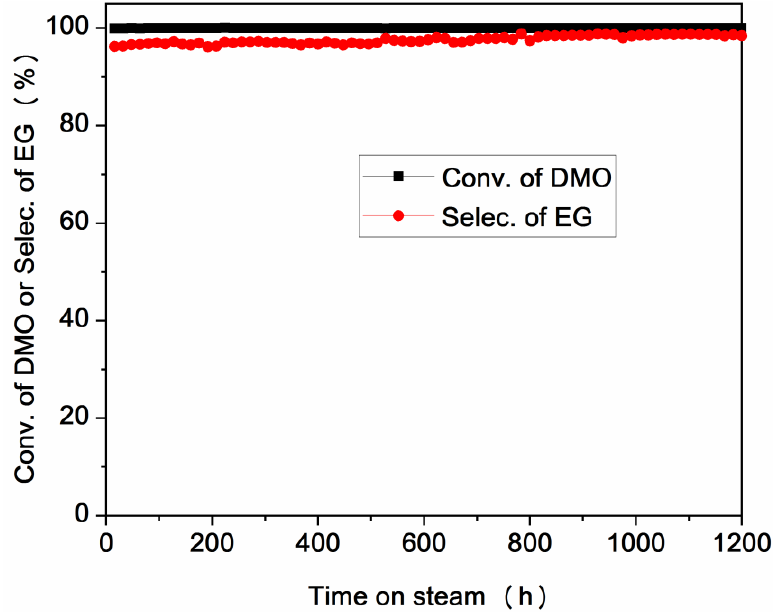
Figure 8. DMO hydrogenation over 0.08E-Cu/SiO 2 catalyst as a function of time on stream. Reaction conditions: T = 180 ◦ C, P(H 2 ) = 2.0 MPa, H 2 /DMO = 100 (mol mol − 1